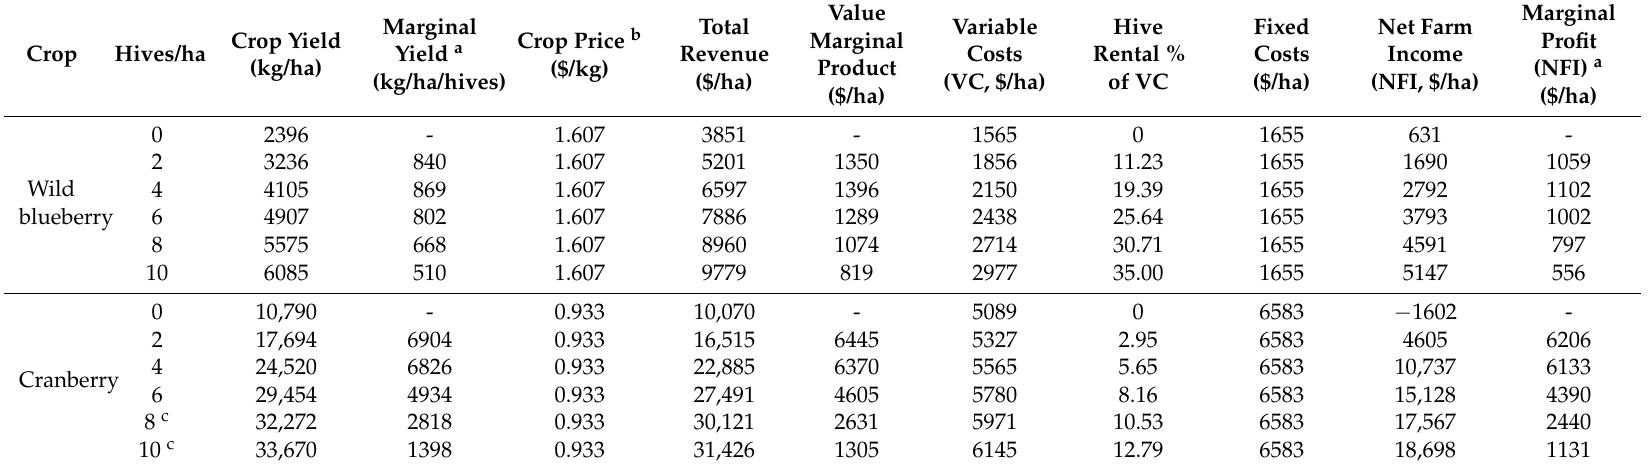
Table 4. Total and marginal output, revenue, and profit per hectare from adding more rented hives for Maine, USA, wild blueberry and Massachusetts, USA, cranberry.